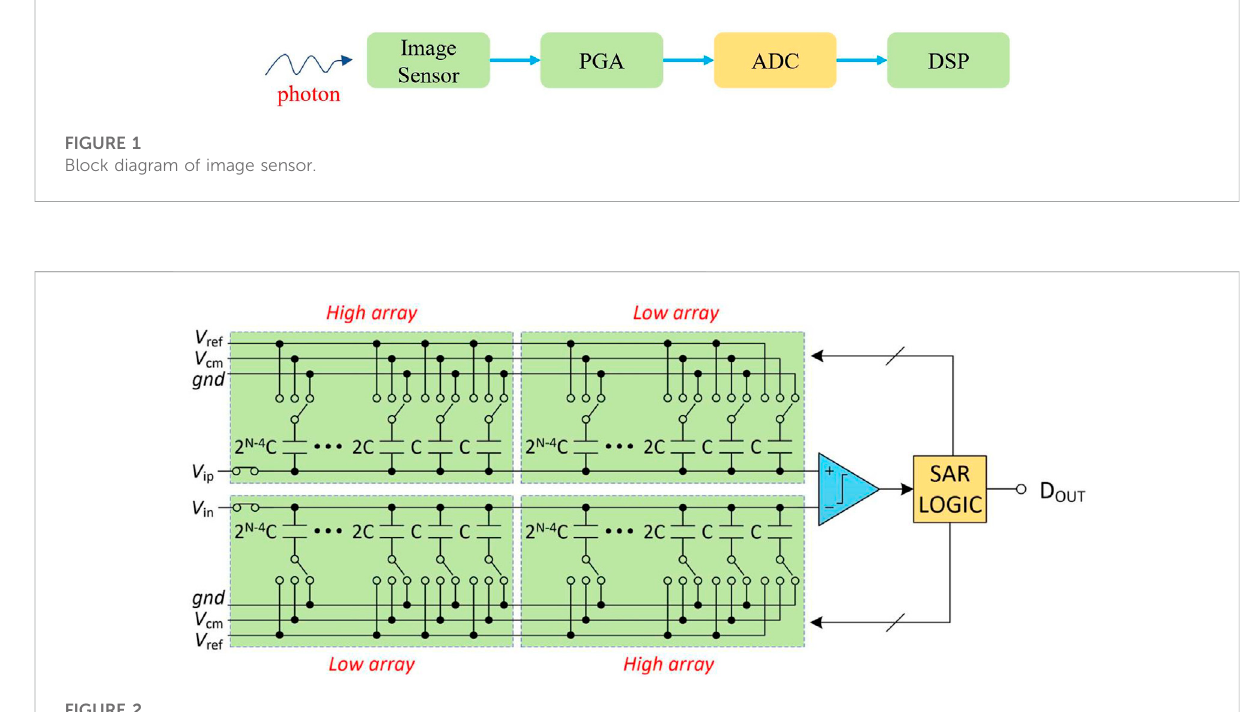
FIGURE 2 The proposed architecture of N-bit SAR